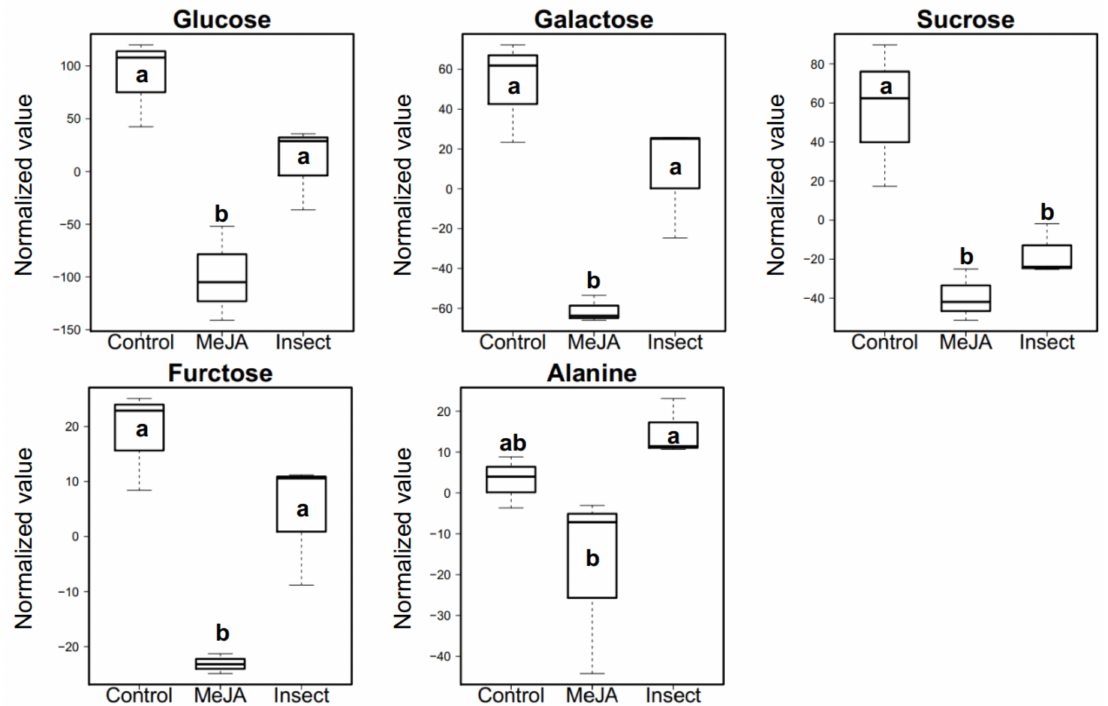
Figure 4. Five biomarker metabolites selected with top-5 variable importance in projection (VIP) scores (VIP > 1.2) from all metabolites among control kales, MeJA-treated kales, and insect-infected kales. Different letter indicates significant differences between the groups, determined by Student’s significance test ( p < 0.05). The presented values are normalized values based on an internal standard with auto-scale in